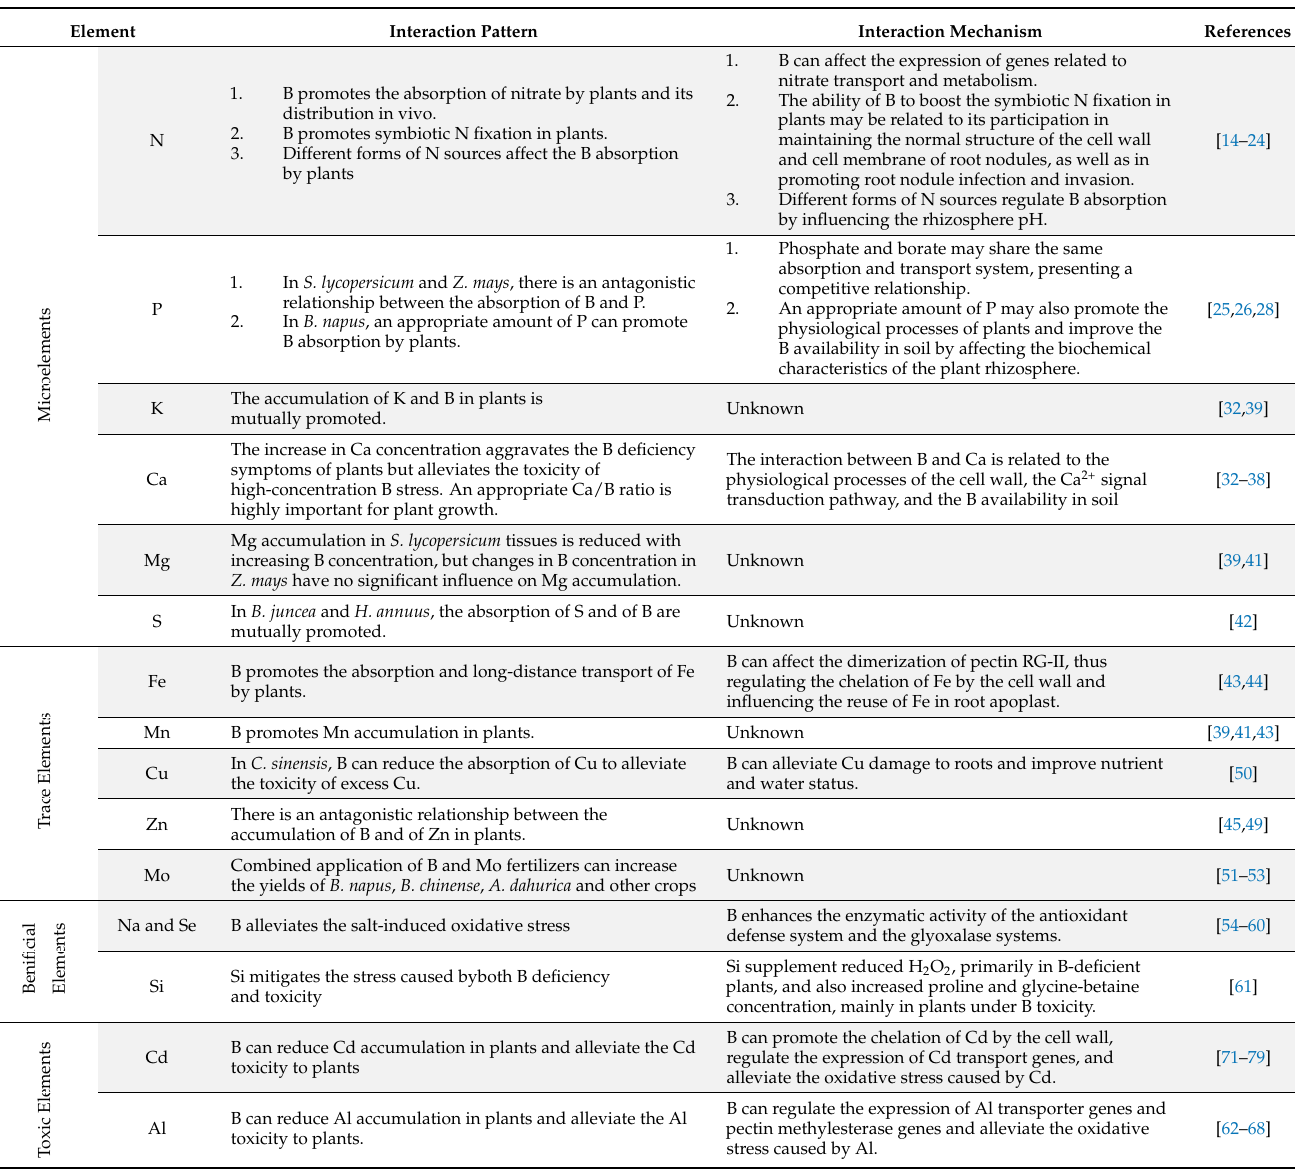
Table 1. Summary of interactions between B and other elements in